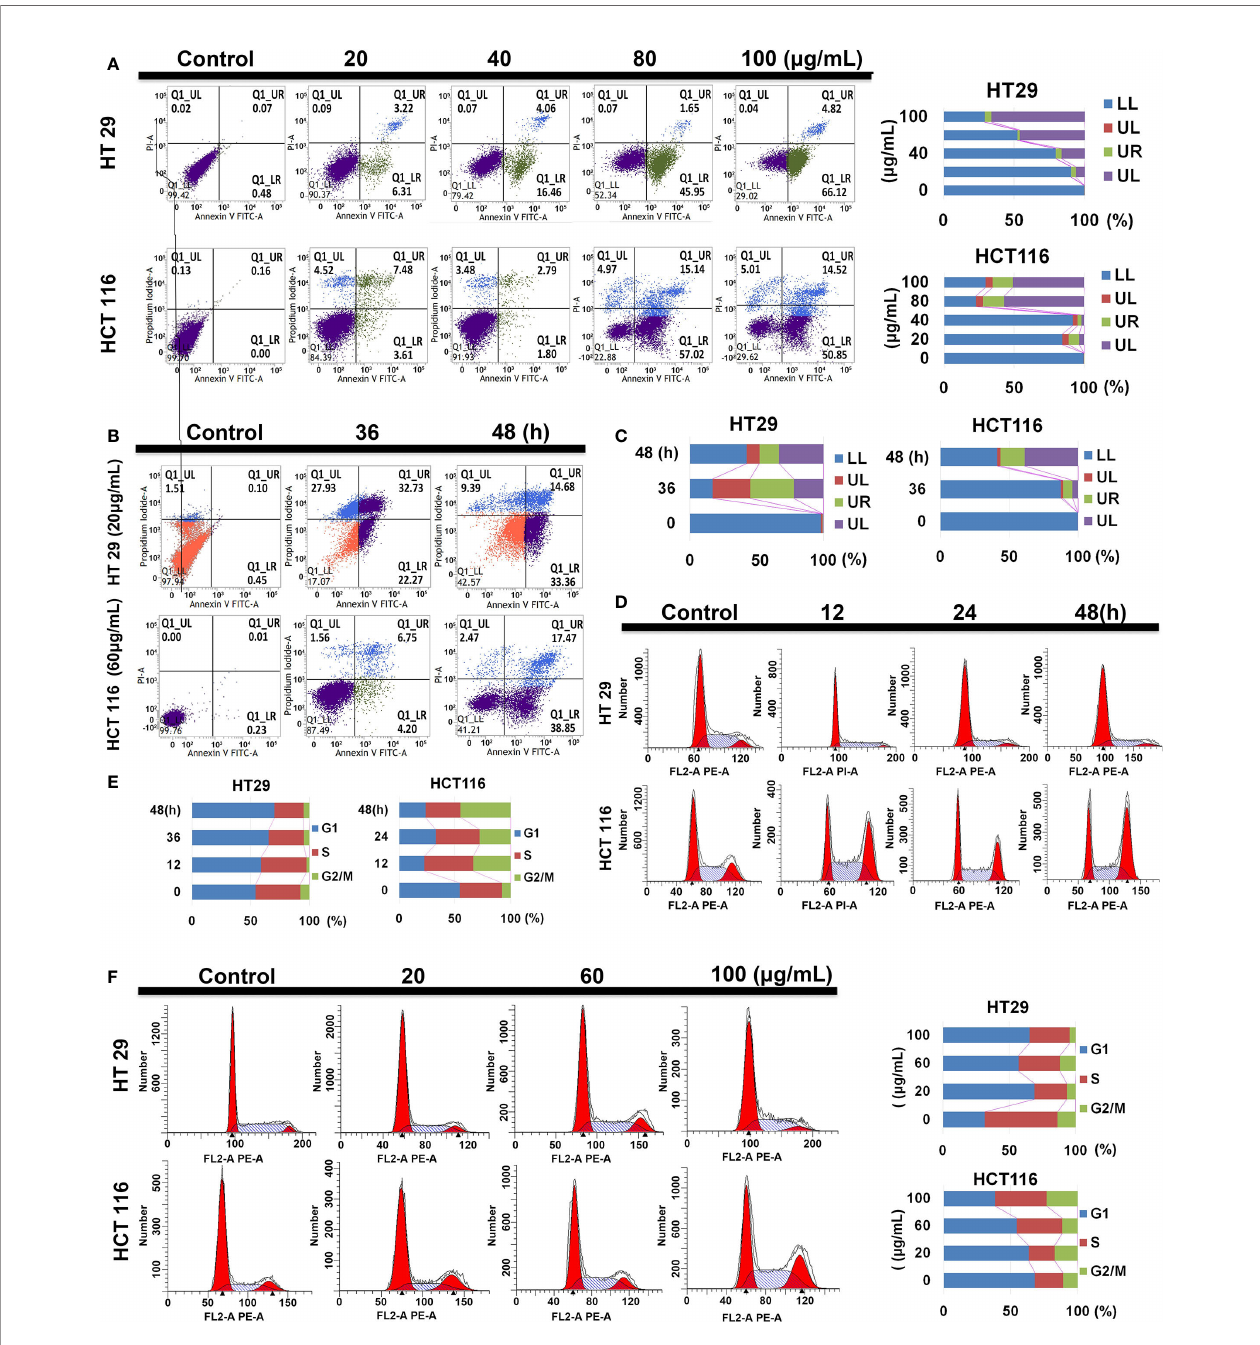
FIGURE 4 | Effect of SDEA on apoptotic rate and cell cycle analysis. (A) apoptotic rate of different concentration-treated HT29 and HCT116 cells for 48 h. (B, C) apoptotic rates of HT29 and HCT116 cells treated with 20 and 60 m g/mL of SDEA at different times ( n = 3), respectively. (D, E) Cell cycle analysis of HT29 and HCT116 cells treated with 100 m g/mL of SDEA at different times, respectively. (F) Cell cycle analysis of HT29 and HCT116 cells treated with different SDEA